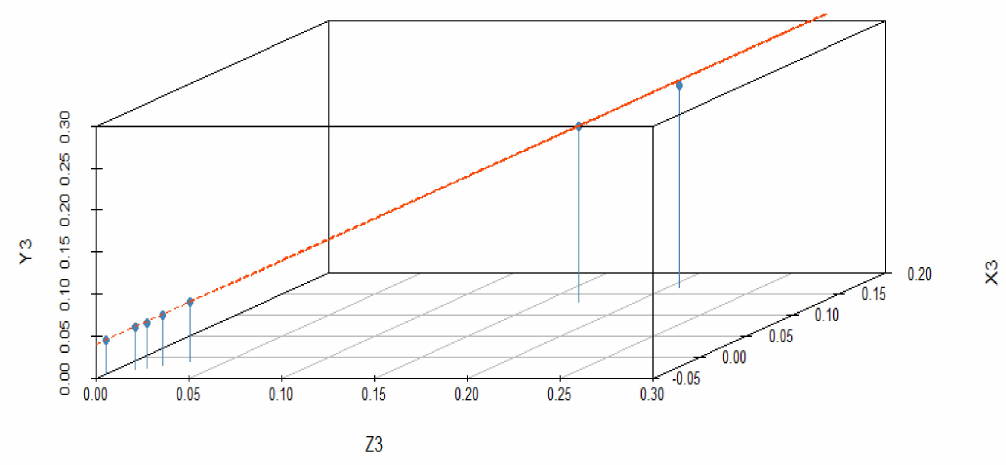
Figure 10. 3D illustration of correlation among the dependent and predictor variables for a difference of 0.04 from the experimentally fixed value at 420 ◦